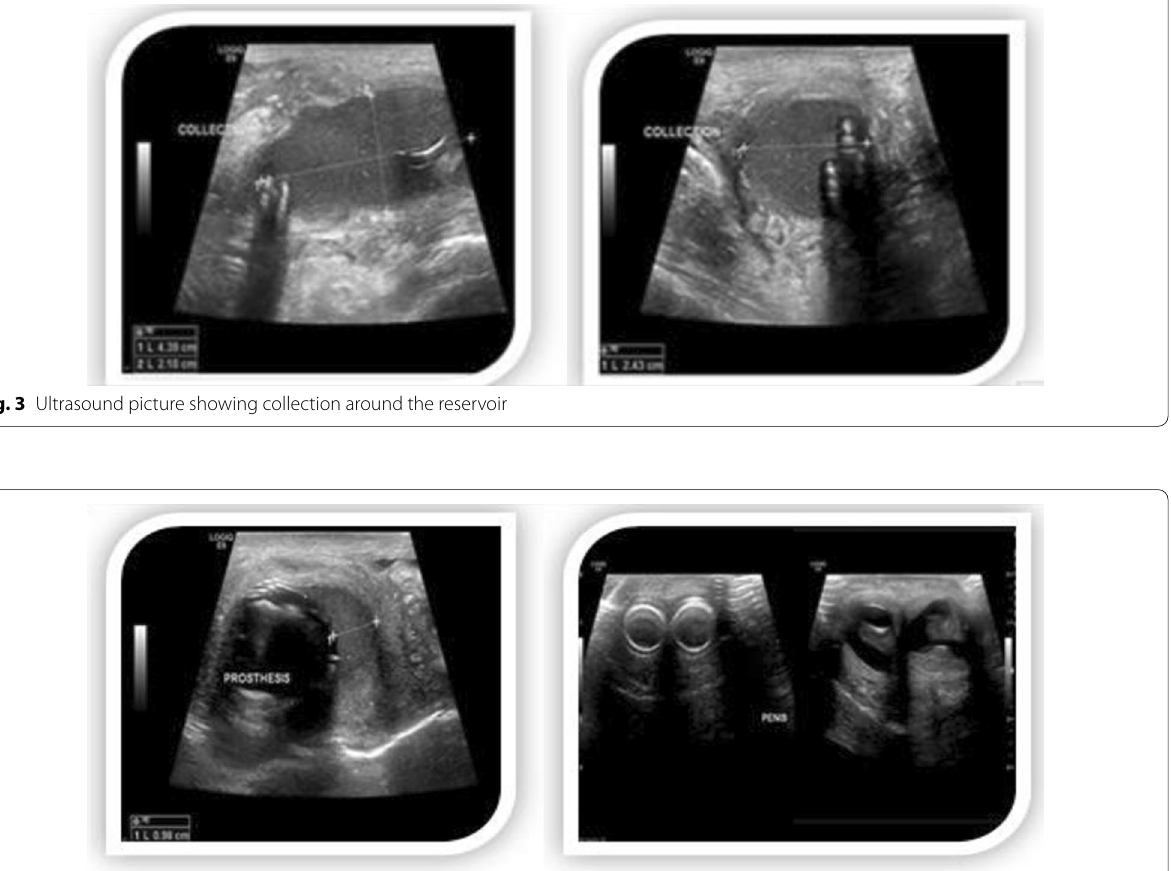
Fig. 4 Ultrasound picture showing collection around the pump and